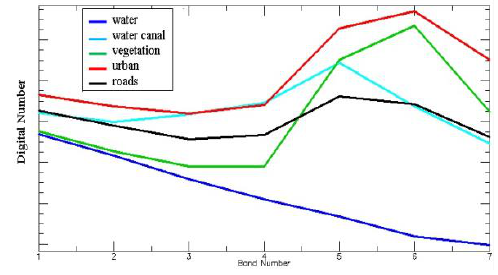
Figure 1: Spectral Curves of various land feature